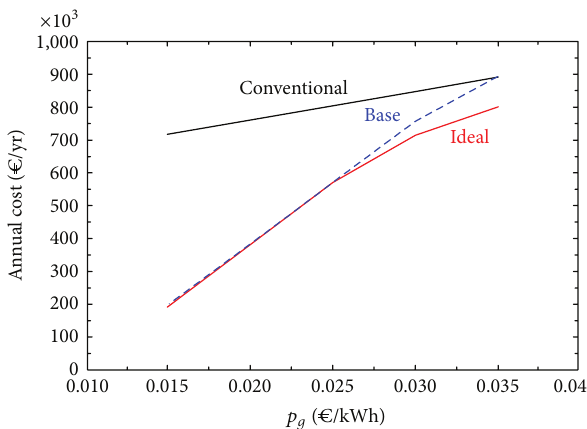
Figure 6: Behavior of solutions in response to variations in the price of natural